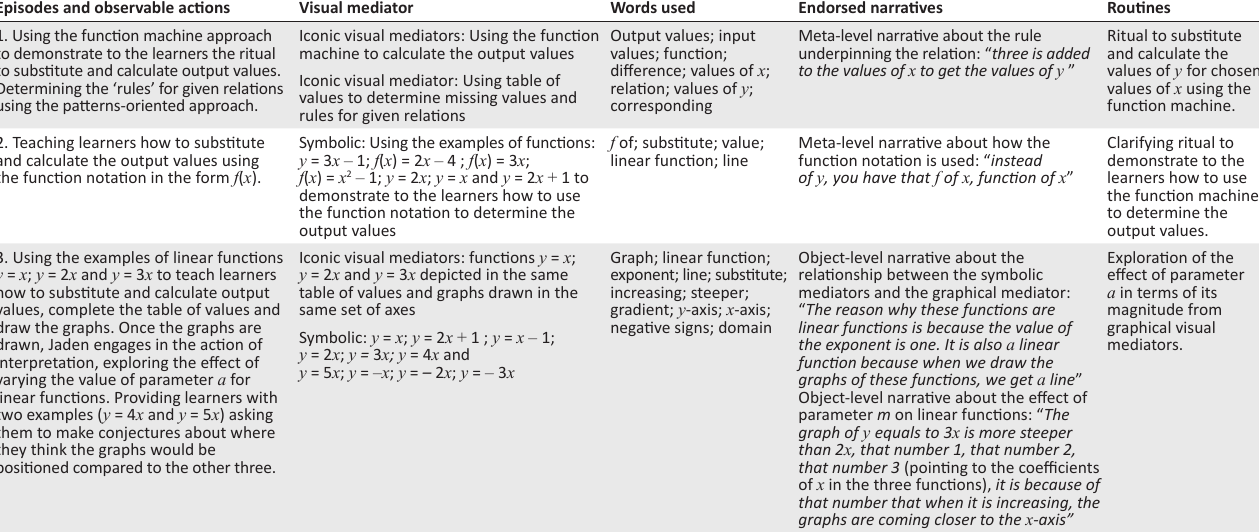
TABLE 6: Discourses in Jaden’s teaching episodes. Episodes and observable